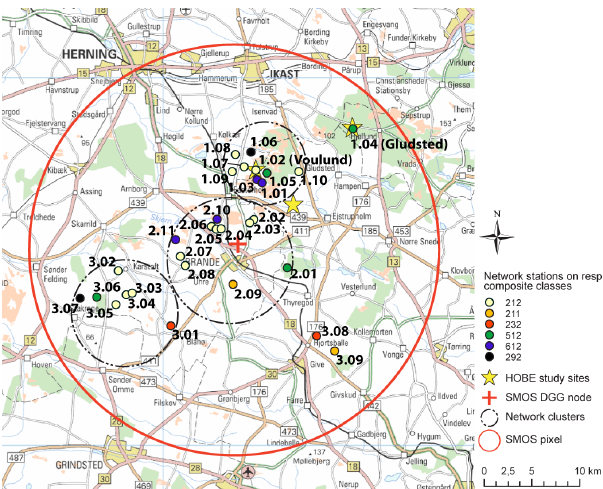
Fig. 2. Overview of the 30 soil moisture network stations installed in the Skjern River Catchment, Western Denmark, within three clus- ters in the selected SMOS pixel around Discrete Global Grid node